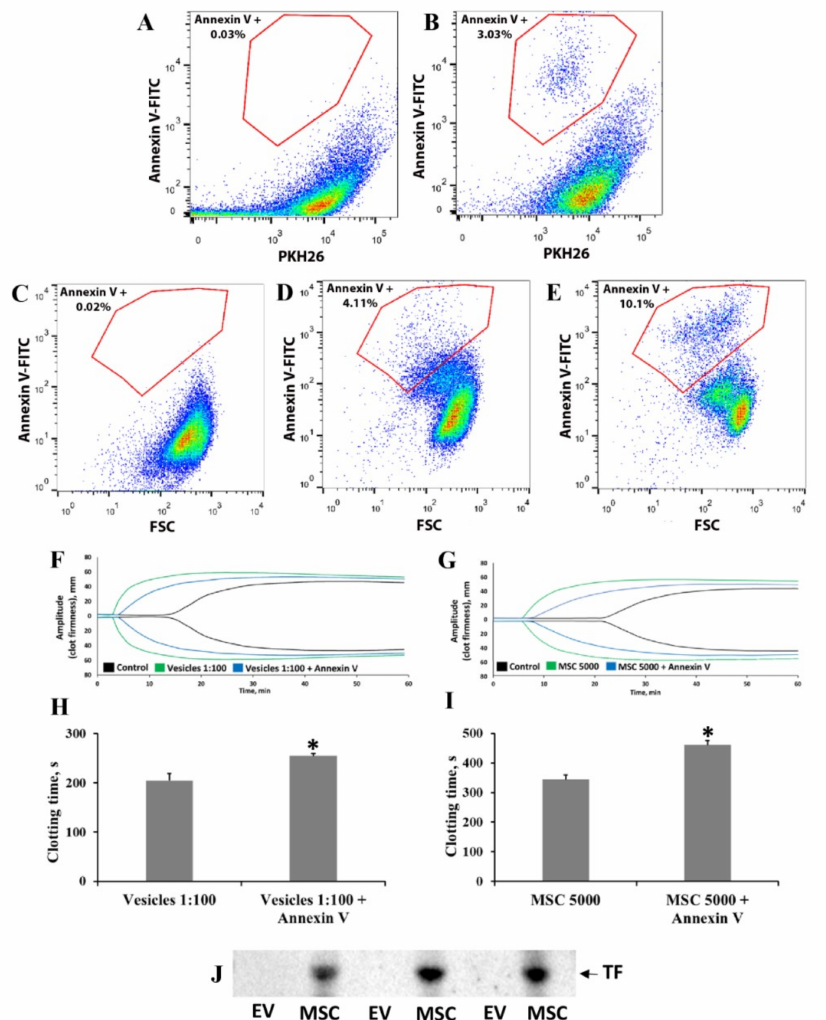
Figure 5. Analysis of phosphatidylserine and tissue factor (TF) expression on MSC and EV surface